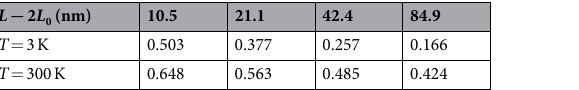
Table 3. Dependence of thermal conductivity reduction T e on the length of the rough edge of the nanoribbon L − 2 L 0 for two values of temperature T = 3 K and T = 300 K. Width of the nanoribbon D a = 1.228 nm, and the defect density p d =